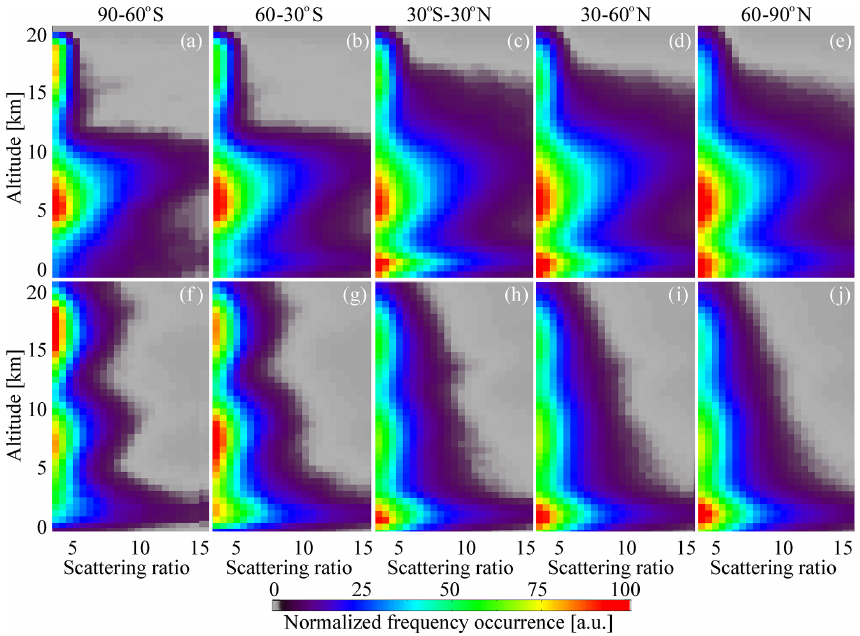
Figure 6. Scattering ratio–height (SR–height) distributions in different latitude zones for the (cid:49) time < 6h, (cid:49) dist < 1 ◦ collocated night- time data subset (see Table 2): (a–e) CALIOP SR ( 532nm ,z) averages and (f–j) SR (cid:48) ( 532nm ,z) estimated from ALADIN extinction and backscatter coefficients. (a, f) 90–60 ◦ S, (b, g) 60–30 ◦ S, (c, h) 30 ◦ S–30 ◦ N, (d, i) 30–60 ◦ N, and (e, j) 60–90 ◦